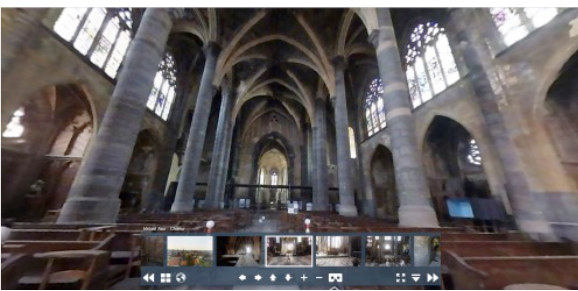
Figure 10 . A subset of the point cloud of the collegiate Sainte Croix church.